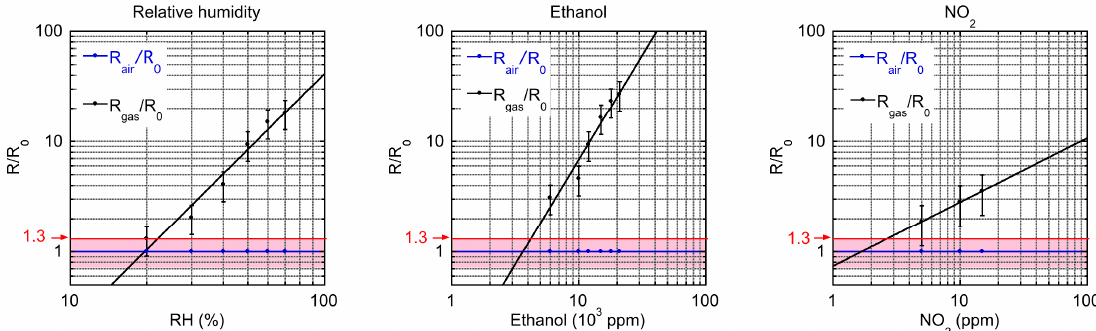
Figure A1. A graphical estimate of the limit of detection (LOD) of different analytes in single InAs nanowire-based sensor: the LOD corresponds to the abscissa at the intersection between the horizontal line at 1.3 and the Rgas/R0 fitting curve for each analyte.